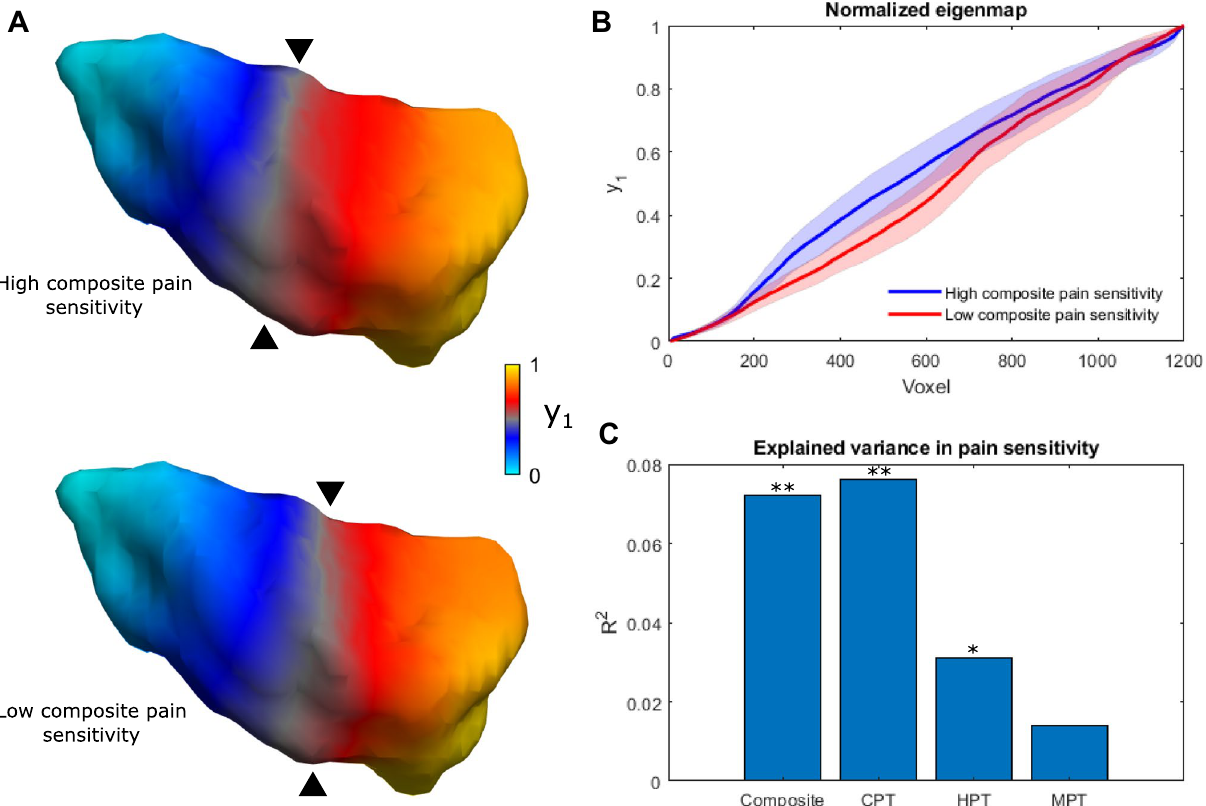
Figure 2. Connectopy of the right insula is associated with pain sensitivity scores. ( A ) The average connectopy of the right insula in participants with high and low composite pain sensitivity (chosen as the upper and lower quintile (< 20% and > 80%) of composite pain sensitivity scores). Apart from posterioanterior steepness, differences in finer spatial variation also contribute to the effect. ( B ) Differences of the connectopy curve in participants with high and low composite pain sensitivity. Shaded areas depict the 95% confidence interval. ( C ) Bar plot showing the contribution of trend surface model parameters to pain sensitivity scores. ** p < 0.01, * p < 0.05, y 1 : dominant connectopy, Composite: composite pain sensitivity, CPT: cold pain threshold, HPT: heat pain threshold, MPT: mechanical pain